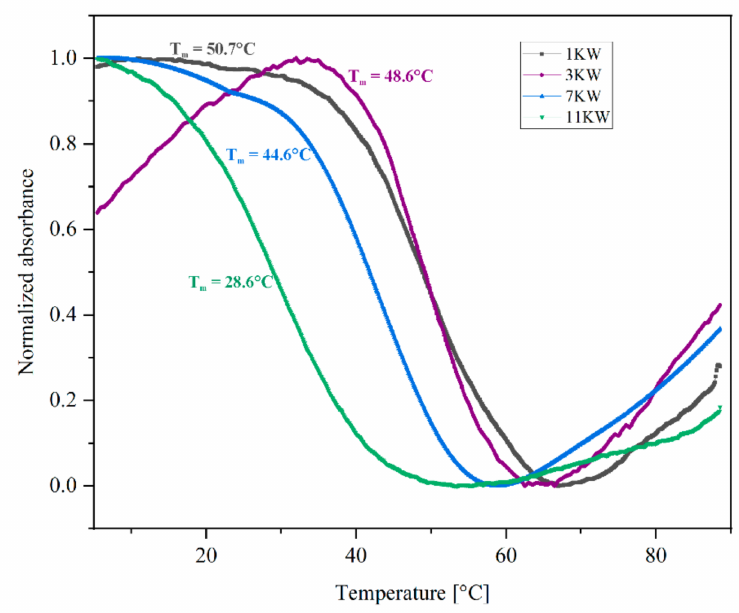
Figure 2. Representative ultraviolet (UV) melting curves of model PQS oligomers with T m values obtained by monitoring the melting profile at 295